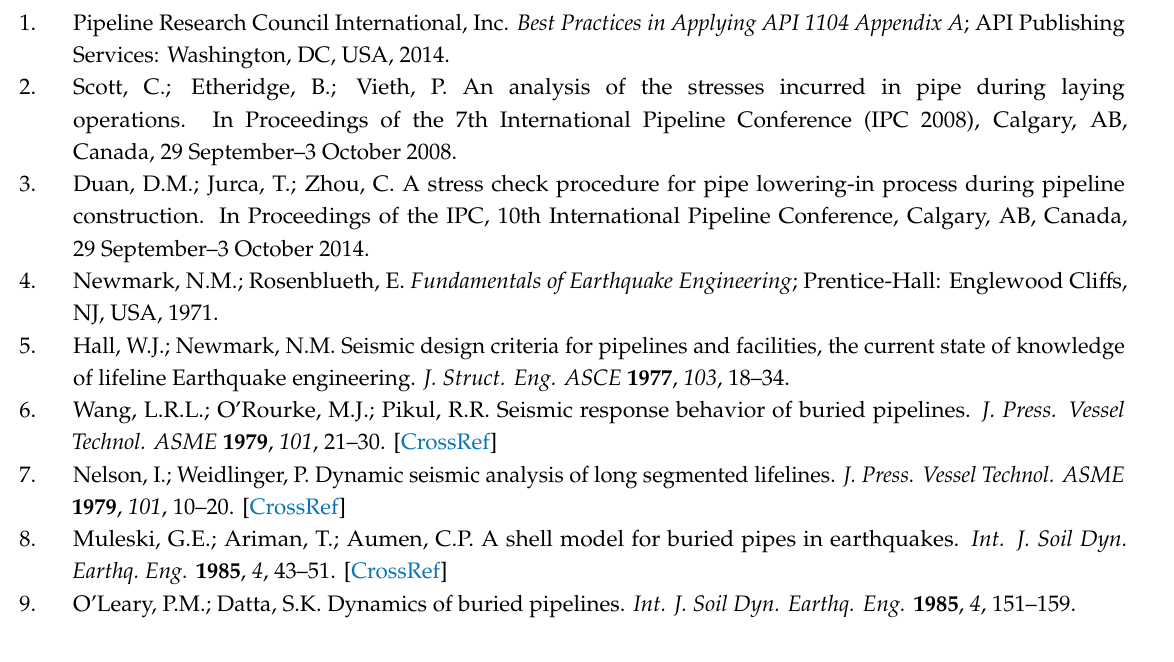
Figure A5. The 3-D analysis results of the segmental pipeline model: ( a ) deflections; ( b ) bending moments obtained by using RMS; ( c ) shear forces obtained by using RMS; ( d ) Von-Mises stress.